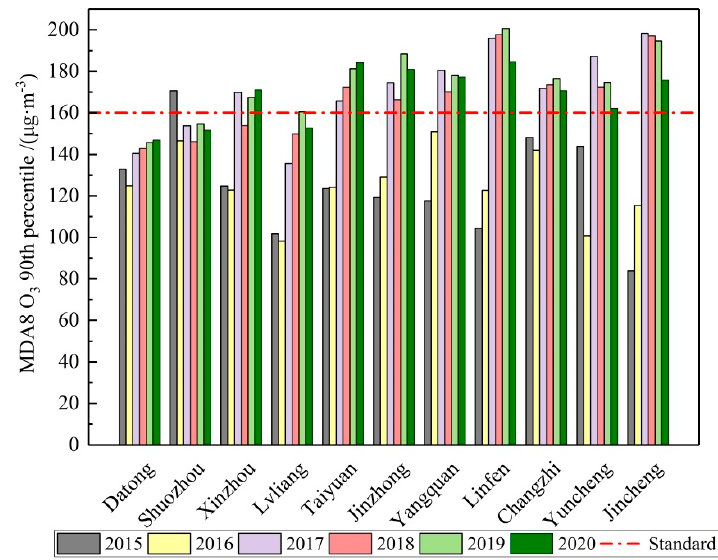
Figure 3. The 90th percentiles of MDA8 O 3 concentration in 11 cities of Shanxi Province from 2015 to 2020. The red dotted line indicates the annual MDA8 O 3 concentration that exceeds the standard.